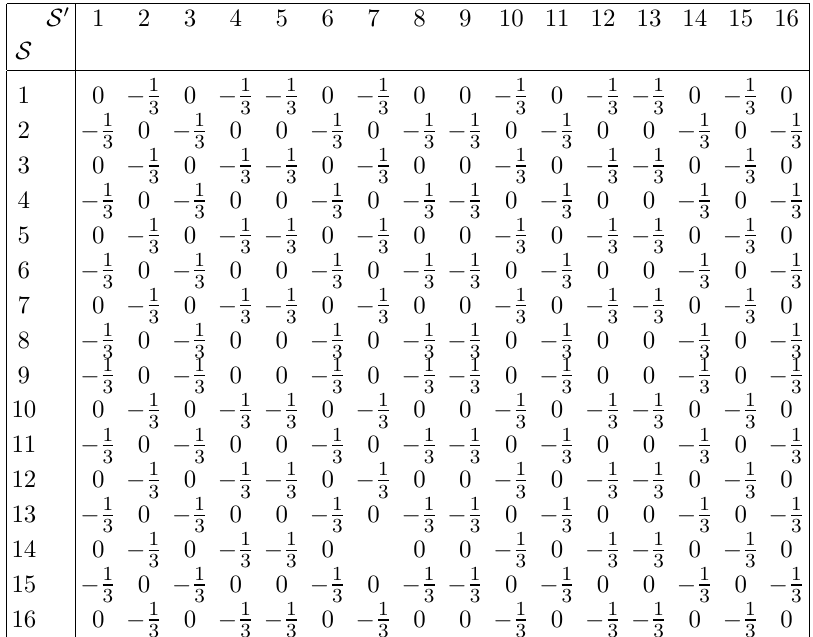
Table 29 . Gadget values for P